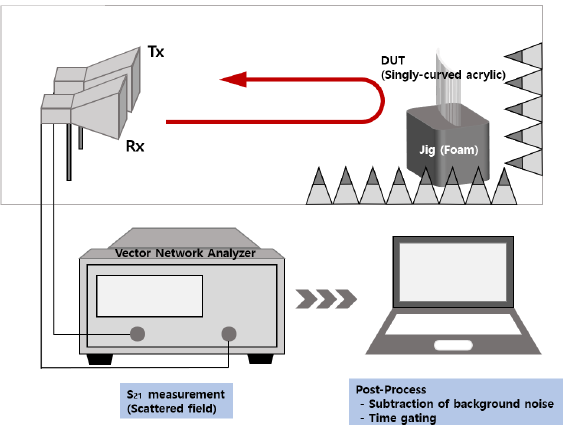
Figure 2. Setup of monostatic RCS measurement with Tx/Rx condition.